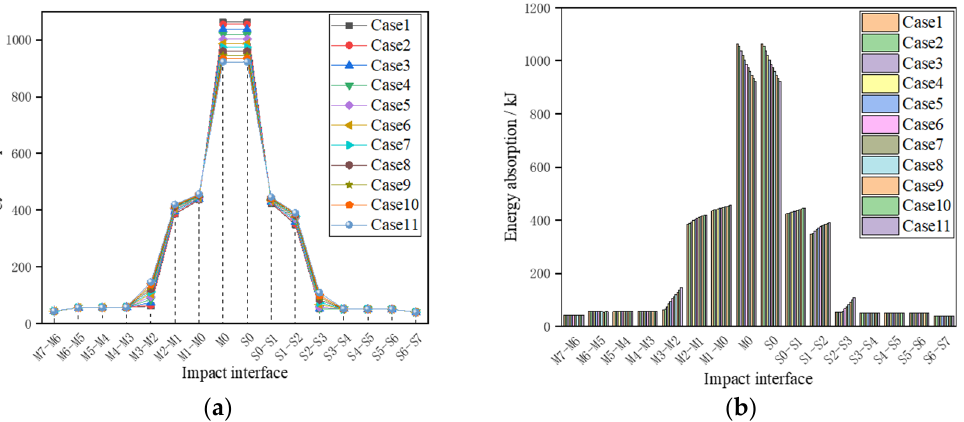
Figure 16. Influence of the slope of platform force change on overall train collision energy: ( a ) broken line graph, ( b ) bar chart.